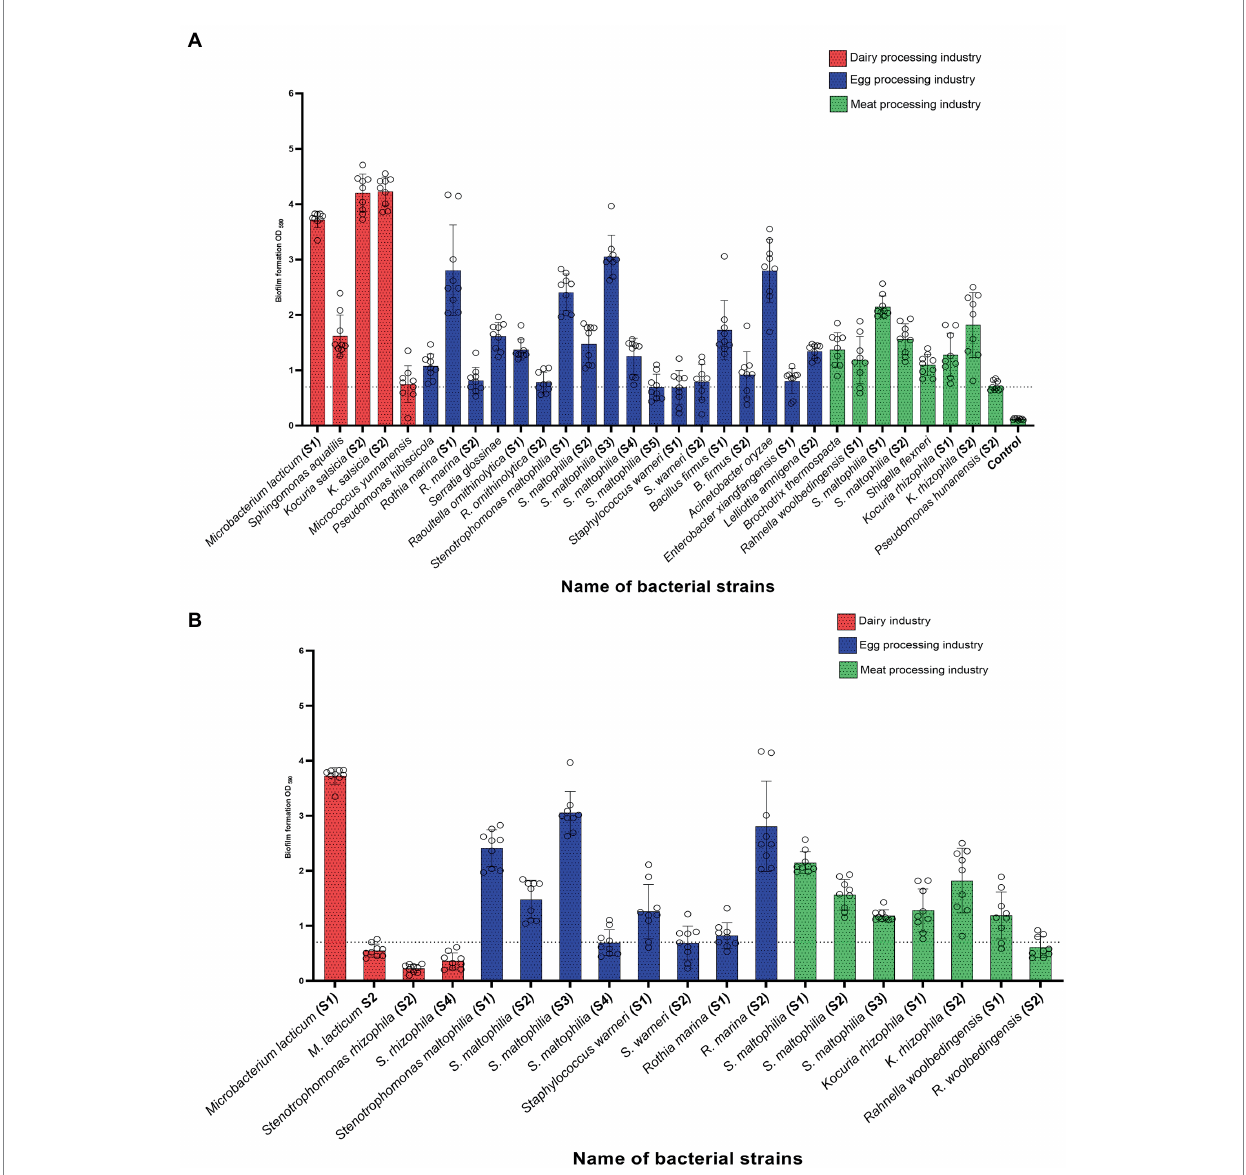
FIGURE 3 (A) High biofilm-forming bacterial strains among 92 isolates collected from food contact surfaces of three industries: dairy, meat, and egg processing industries after routine cleaning and disinfection. (B) shows strain-level variation in the biofilm-forming ability of the strains from each industry. The horizontal dotted line in both parts of the figure indicates the OD cut-off value for strong biofilm